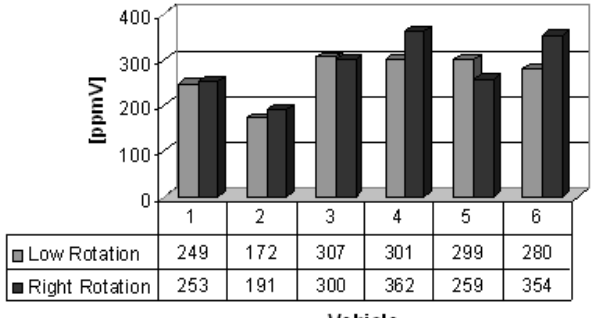
Figure 10. Sulfur dioxide gas concentrations [ppmV].